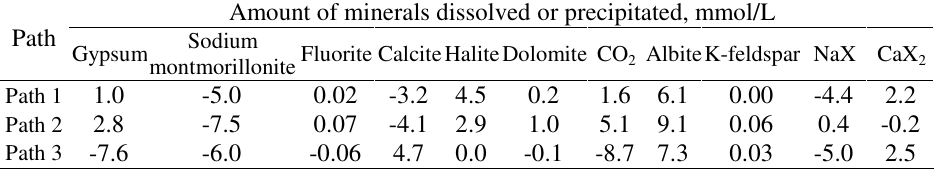
Table 5. Calculation results of amount of minerals dissolved or precipitated Amount of minerals dissolved or precipitated, mmol/L Path Sodium Gypsum Fluorite CalciteHaliteDolomite CO 2 AlbiteK-feldspar NaX CaX 2 montmorillonite Path